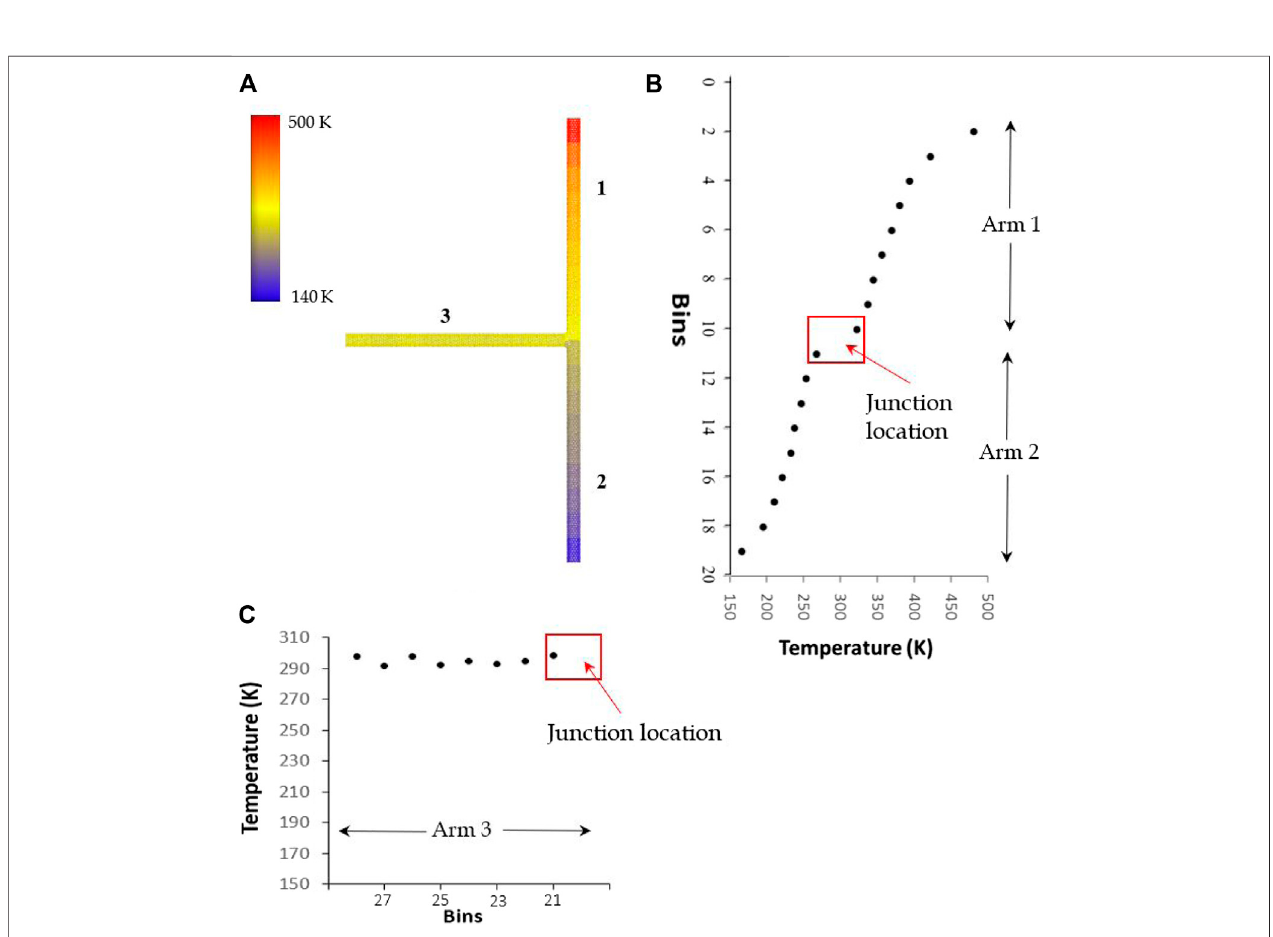
FIGURE7| Thermalgradientina3T-Junctionduetothermalexcitationalongthelongitudinaldirection. (A) Thermalgradientinthe3Tjunctionrepresentedbycolor scales. (B) Temperature pro fi le along arms 1 and 2. (C) temperature pro fi le along arm 3.